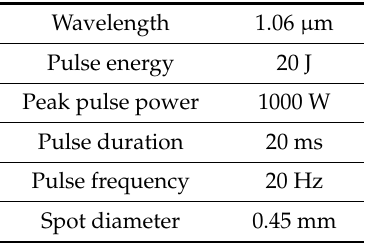
Table 4. Welding parameters used in present studies.